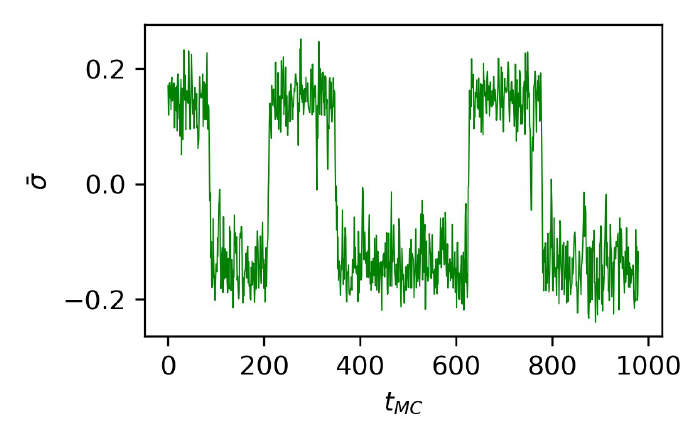
Figure 1: Fluctuations of ¯ σ values for lattice configurations during HMC simulation in between two minima at λ (cid:175) λ crit